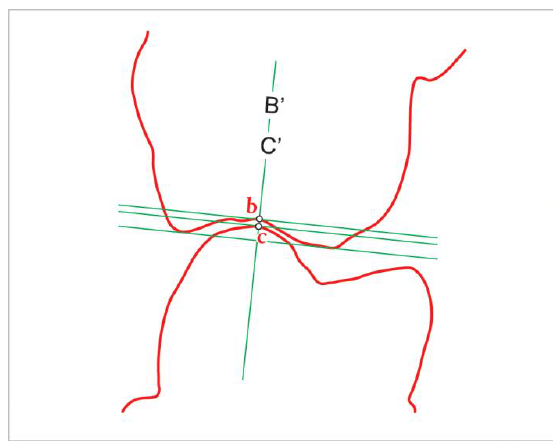
Figure 9a. Occlusiometry on tooth contours. Example of cusp penetration measurements.